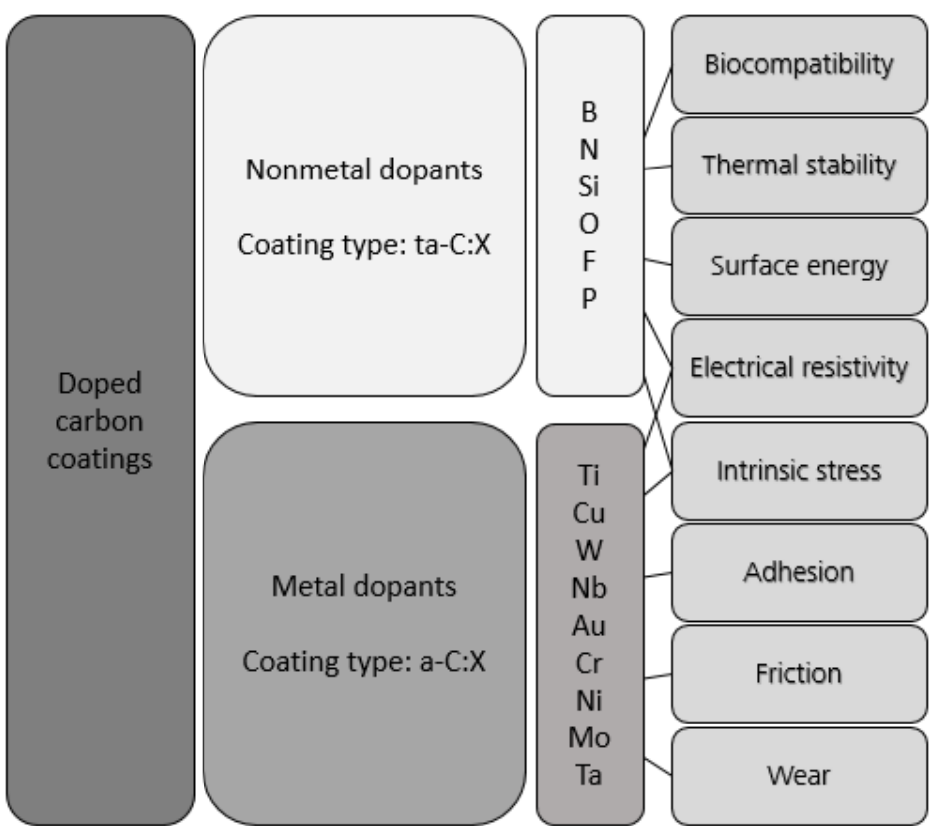
Figure 1. Effect of dopants on the properties of doped carbon coating; modified from